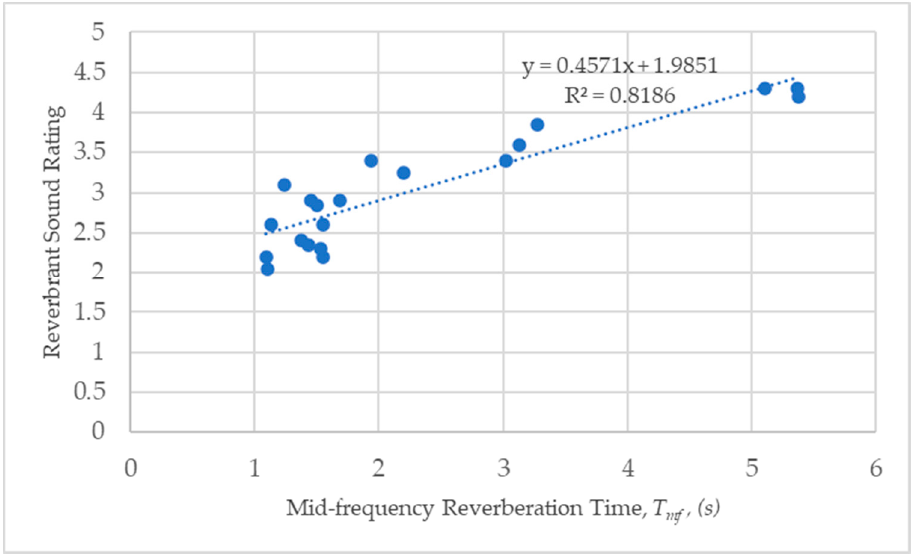
Figure 13. Rating of reverberant sounds and mid-frequency reverberation time, T mf (s), measurements.